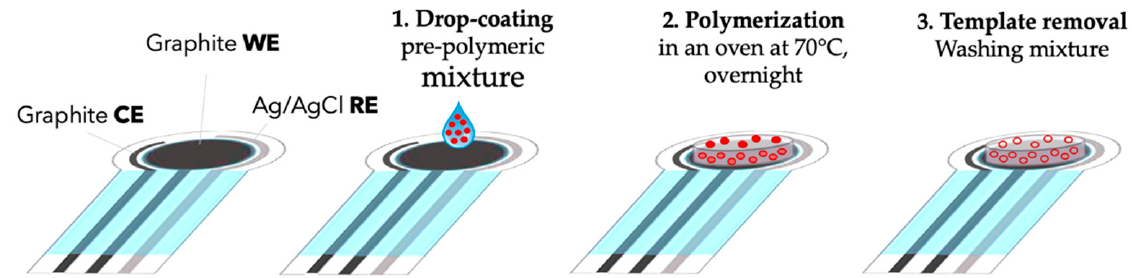
Figure 2. Schematic representation of MIP-modified screen-printed cell assembly.